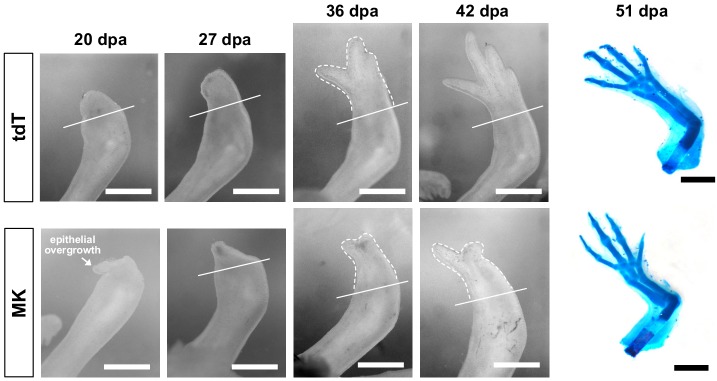
Mk-overexpressing limbs resolve epithelial overgrowth and undergo delayed regeneration.Representative time course images of control tdTomato (top) or mk-overexpressing (bottom) regenerating limbs at 20, 27, 36, and 42 dpa (N = 9/12 animals exhibited a substantial delay in regeneration). Alcian-stained regenerated limbs at 51 dpa are shown on the far right. Scale bars, 1 mm. dpa, days post-amputation.